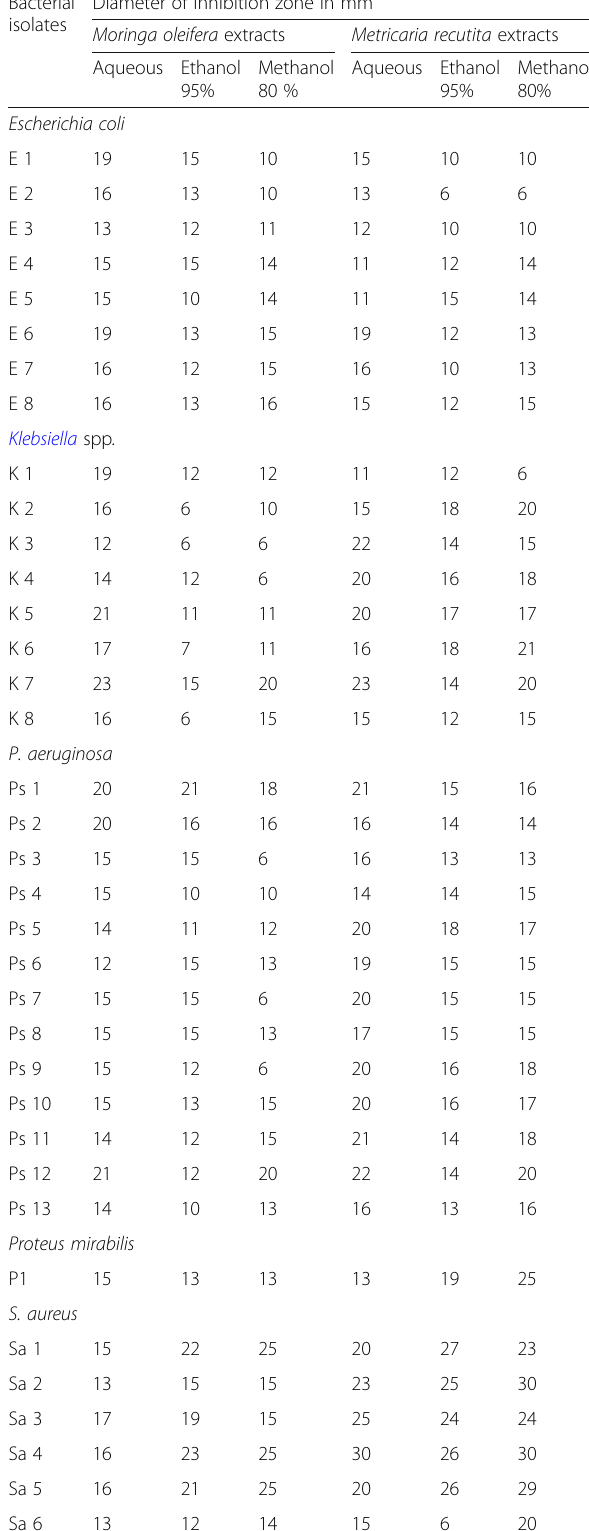
Table 5 Antimicrobial activity (in mm) of plant extracts against tested bacterial isolates Bacterial Diameter of inhibition zone in mm isolates